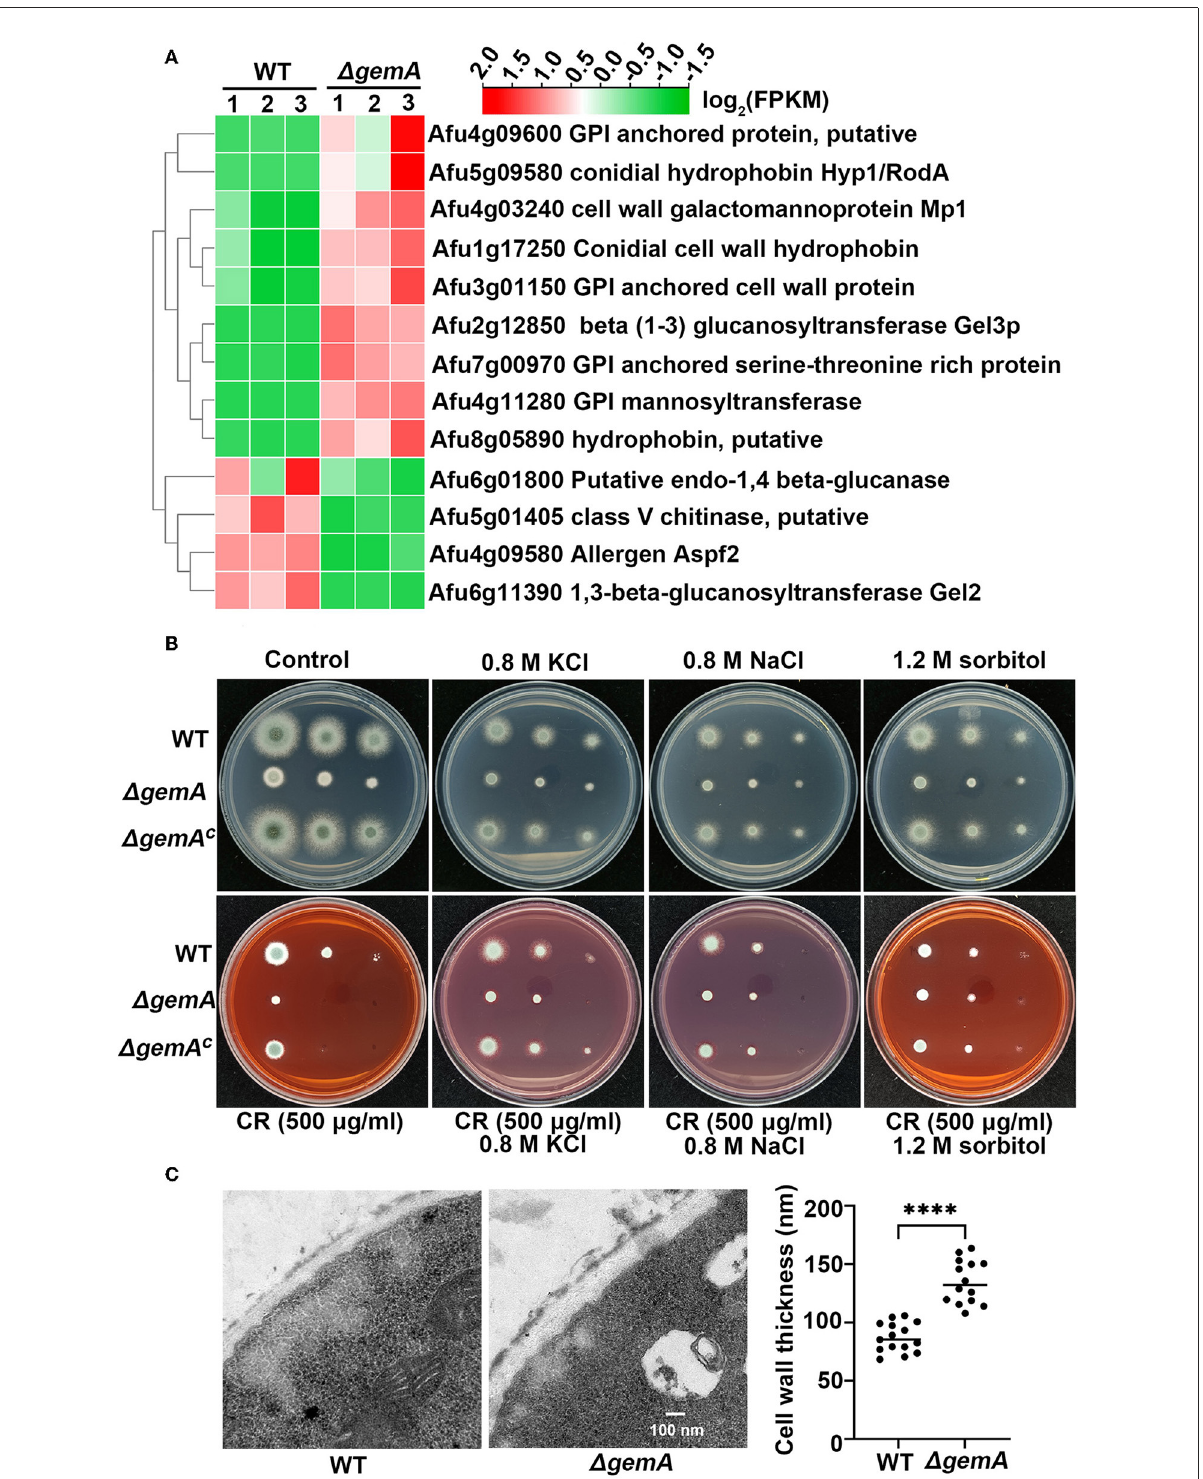
FIGURE6 GemA is required for response to cell wall stress in A. fumigatus . (A) A heatmap comparison of cell wall-related genes between the gemA mutant and its parental WT strain by using RNA-seq data. (B) A colony phenotype comparison of the indicated strains in MM with or without a cell wall-perturbing reagent Congo red and hyperosmotic stress regents (KCl, NaCl, and sorbitol) at 37 ◦ C for 2 days. (C) The transmission electron microscopy images and quantitative data of cell wall thickness of the gemA mutant and its parental WT strain. **** P <